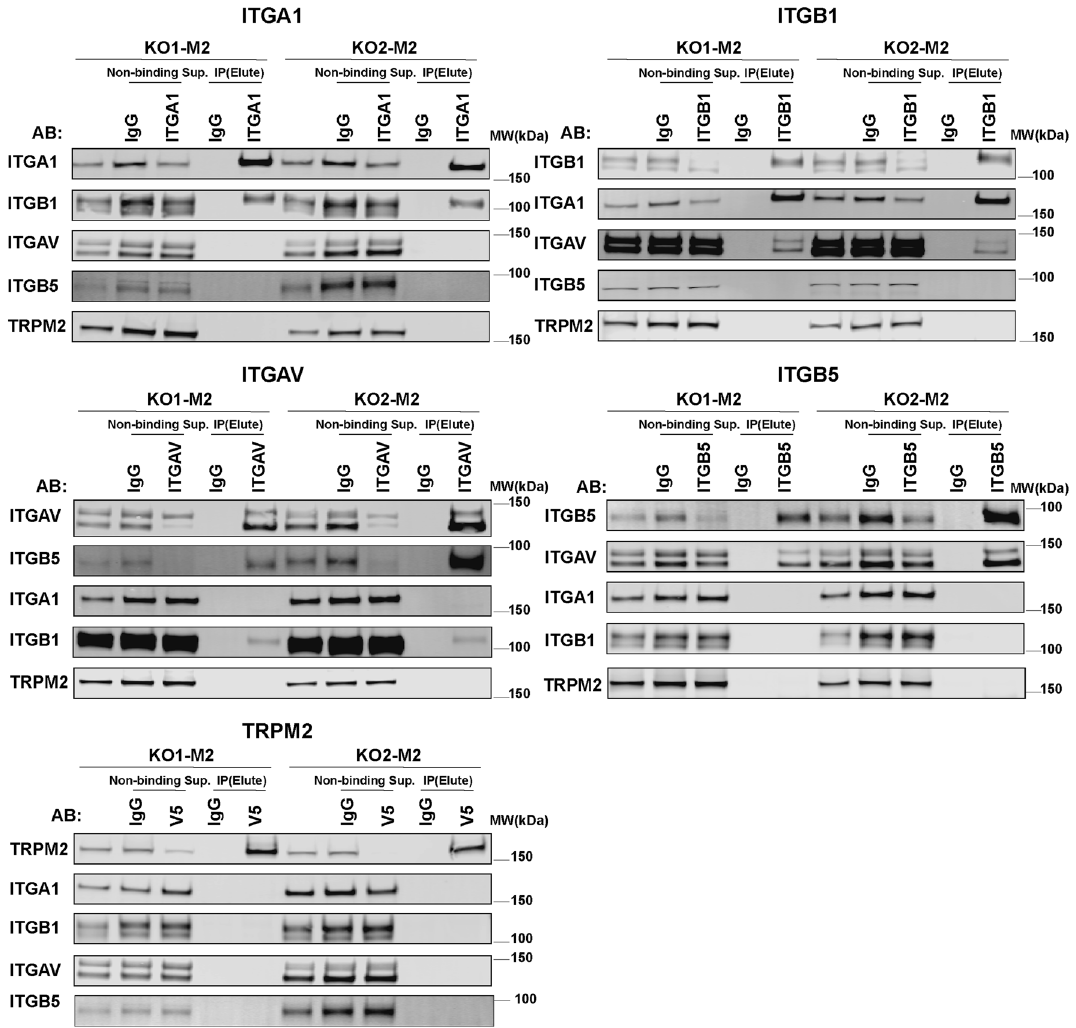
Figure 5. Immunoprecipitation of integrin complexes in TRPM2 expressing cells. Integrins α1 (ITGA1), αv (ITGAV), β1 (ITGB1), β5 (ITGB5) were immunoprecipitated (IP) from SH-SY5Y cells with TRPM2 deletion reconstituted with TRPM2, grown without serum for 24 h, with each integrin antibody, or nonspecific IgG. Western blotting of immunoprecipitates was performed on nonbinding supernatants and eluates of bound proteins with the same antibodies. Anti-V5 antibody was used to immunoprecipitate V5-labeled TRPM2, and anti-TRPM2 C-terminal antibody was used for Western blotting. A sample of cell lysate (20 µg/15 µl) was loaded in the first lane to demonstrate starting proteins, and 30 µg/15 µl was loaded in non-binding supernatant lanes. Two experiments were performed with each antibody. Integrin α1 co-precipitated reciprocally with β1, and αv coprecipitated reciprocally with β5 and β1. Representative results are shown. None of the integrins co-precipitated with TRPM2. Full length gels for Western blots are shown in Supplementary Fig.